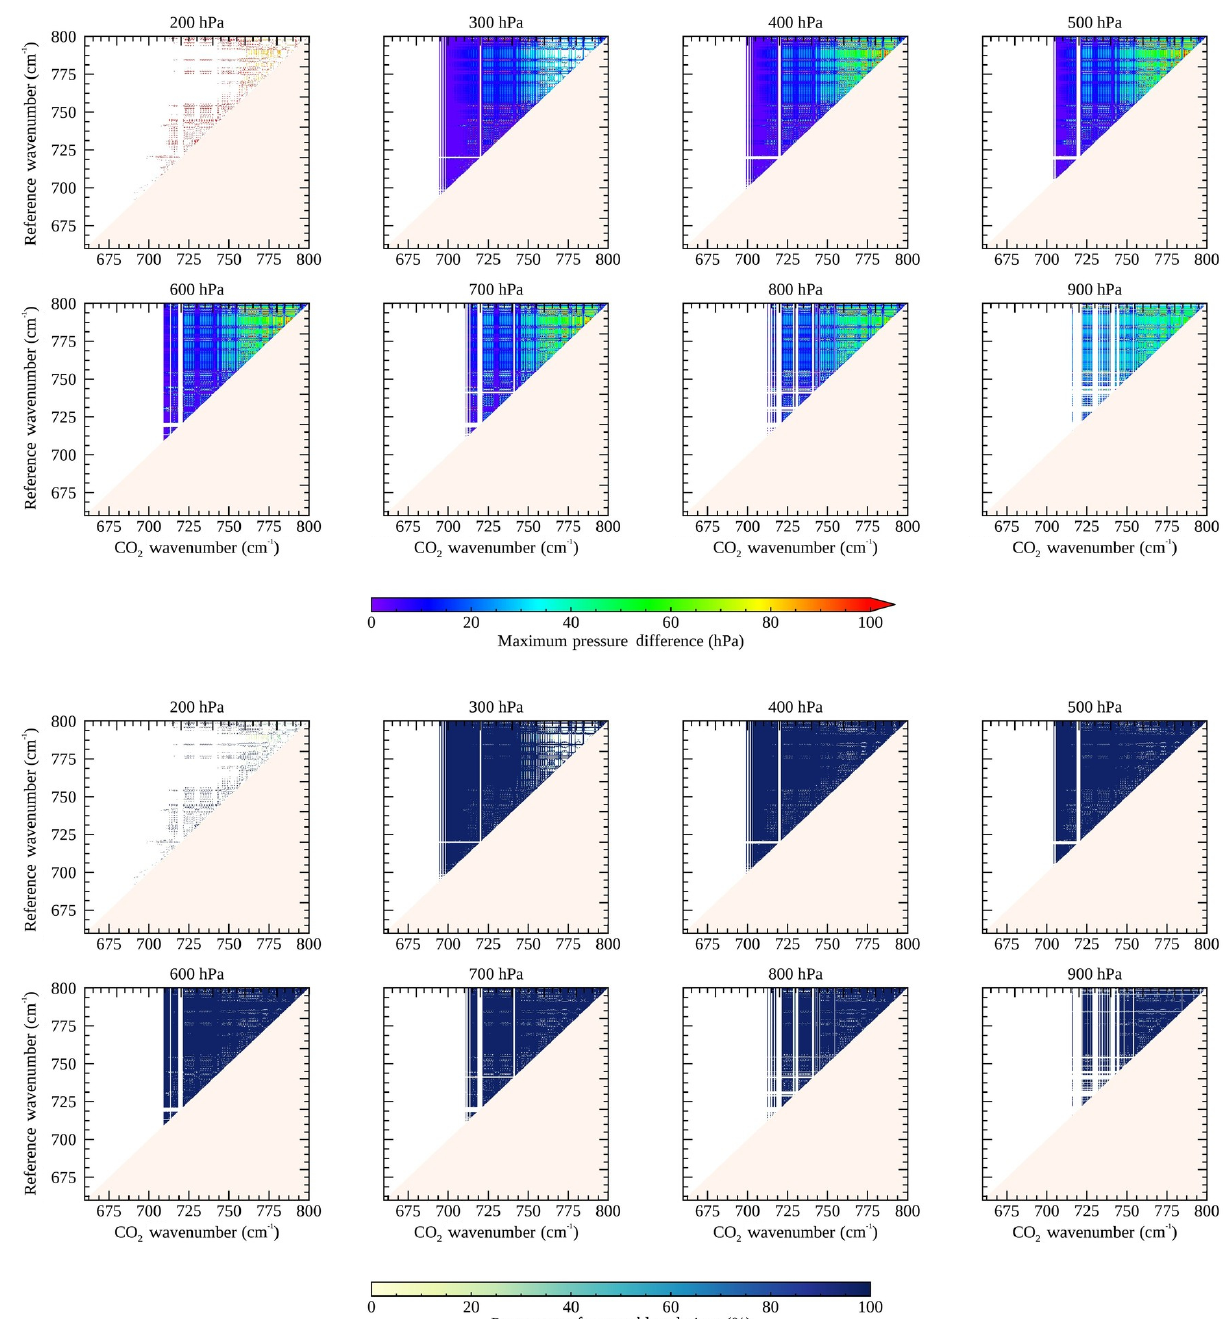
Figure A4. Same as Fig. A1 for a tropical